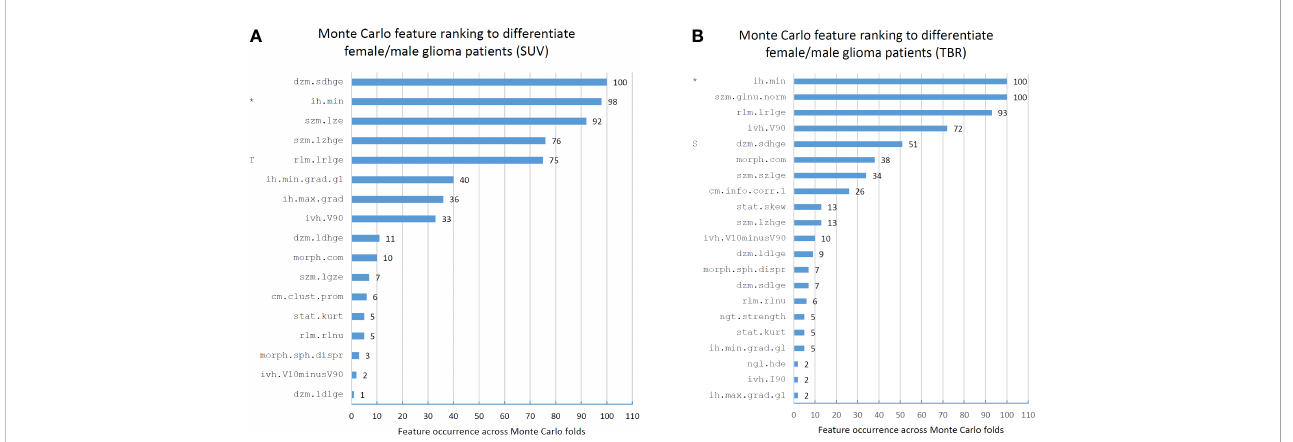
FIGURE 3 Feature occurrences of the 10 highest-ranking features per Monte Carlo fold that separate male and female patients in standard uptake value (SUV)- based (A) and tumor-to-background ratio (TBR)-based (B) radiomic datasets. Pre fi x “ T ” in the SUV feature ranks imply that the given feature was selected as high-ranking (>90% occurrence) in the TBR dataset. Similarly, pre fi x “ S ” in the TBR feature ranks denote a high-ranking SUV feature. Co-occurring high-ranking features in both SUV and TBR datasets are denoted by “ * ” . Features are denoted by their Imaging Biomarker Standardization Initiative (IBSI) identi fi ers. For the names of each feature see Supplemental Table